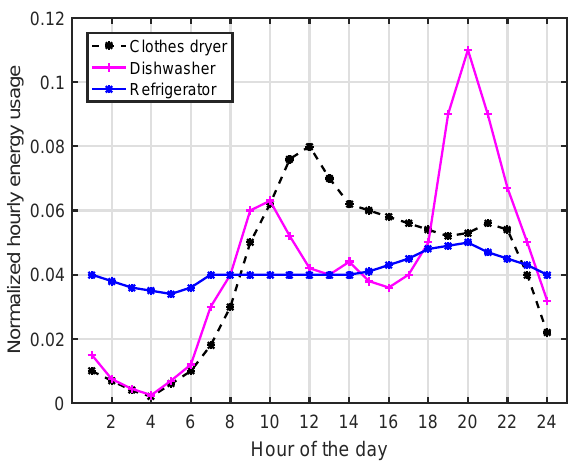
Figure 3. Energy Profile of